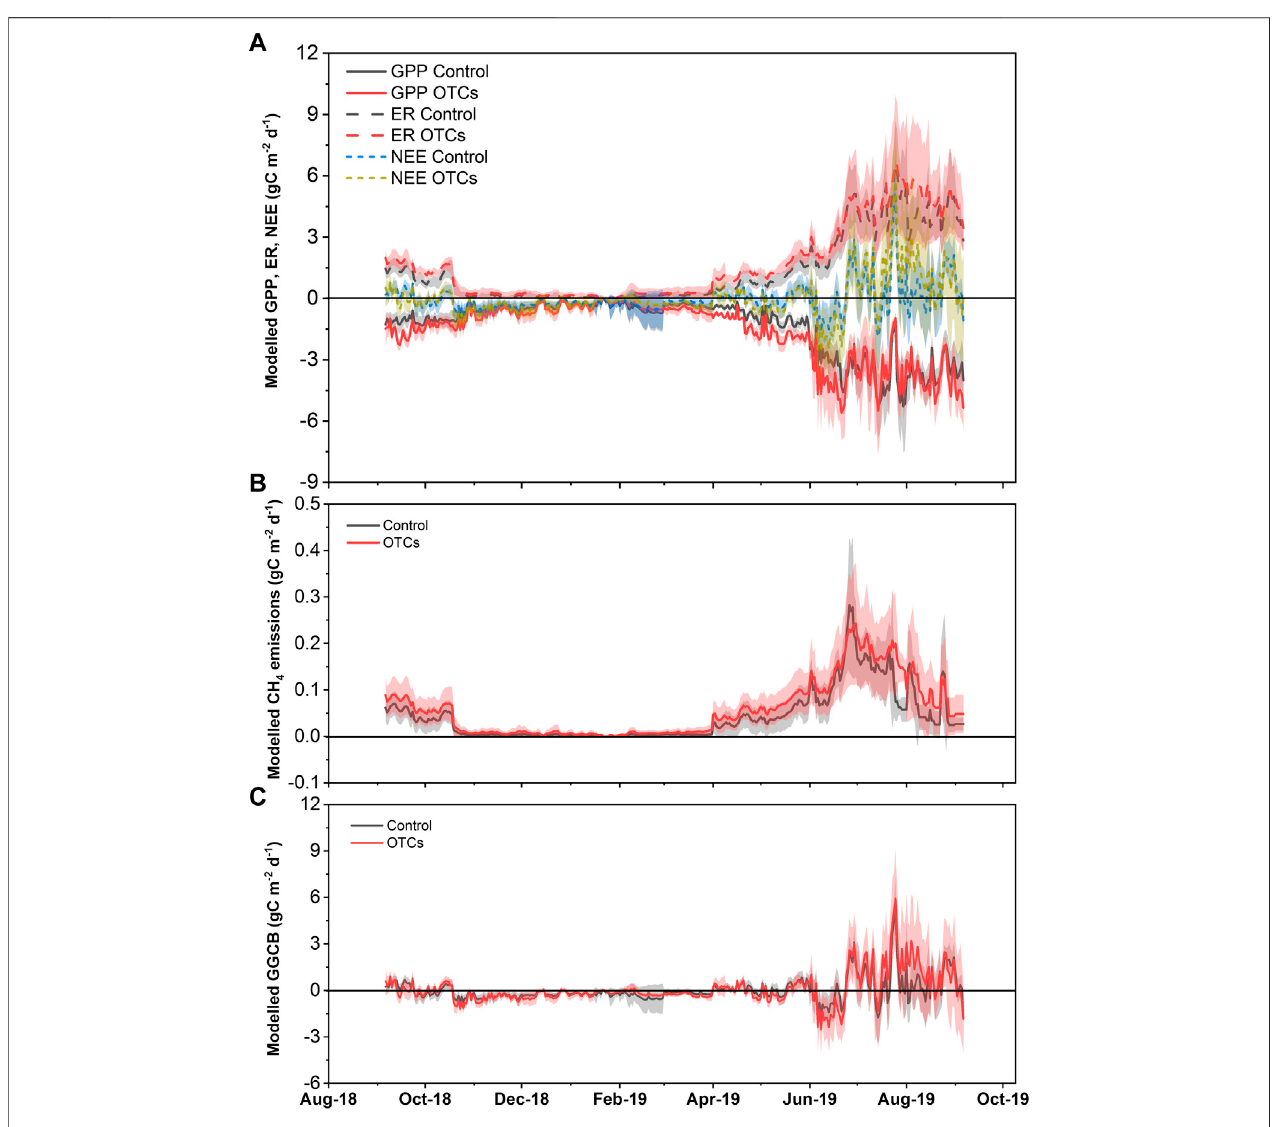
FIGURE 3 | Modeled daily cumulated (A) GPP (gC m − 2 d − 1 ; solid lines), ER (gC m − 2 d − 1 ; dash lines), NEE (gC m − 2 d − 1 ; short dash lines), (B) CH 4 emissions (gC m − 2 d − 1 ),and (C) greenhousegascarbonbudget(GGCB;gC m − 2 d − 1 )fromSeptember2018toSeptember2019incontrolandOTCplots.Linesindicatethemean values of replicates, and colored shading indicates the error bars of standard deviation.